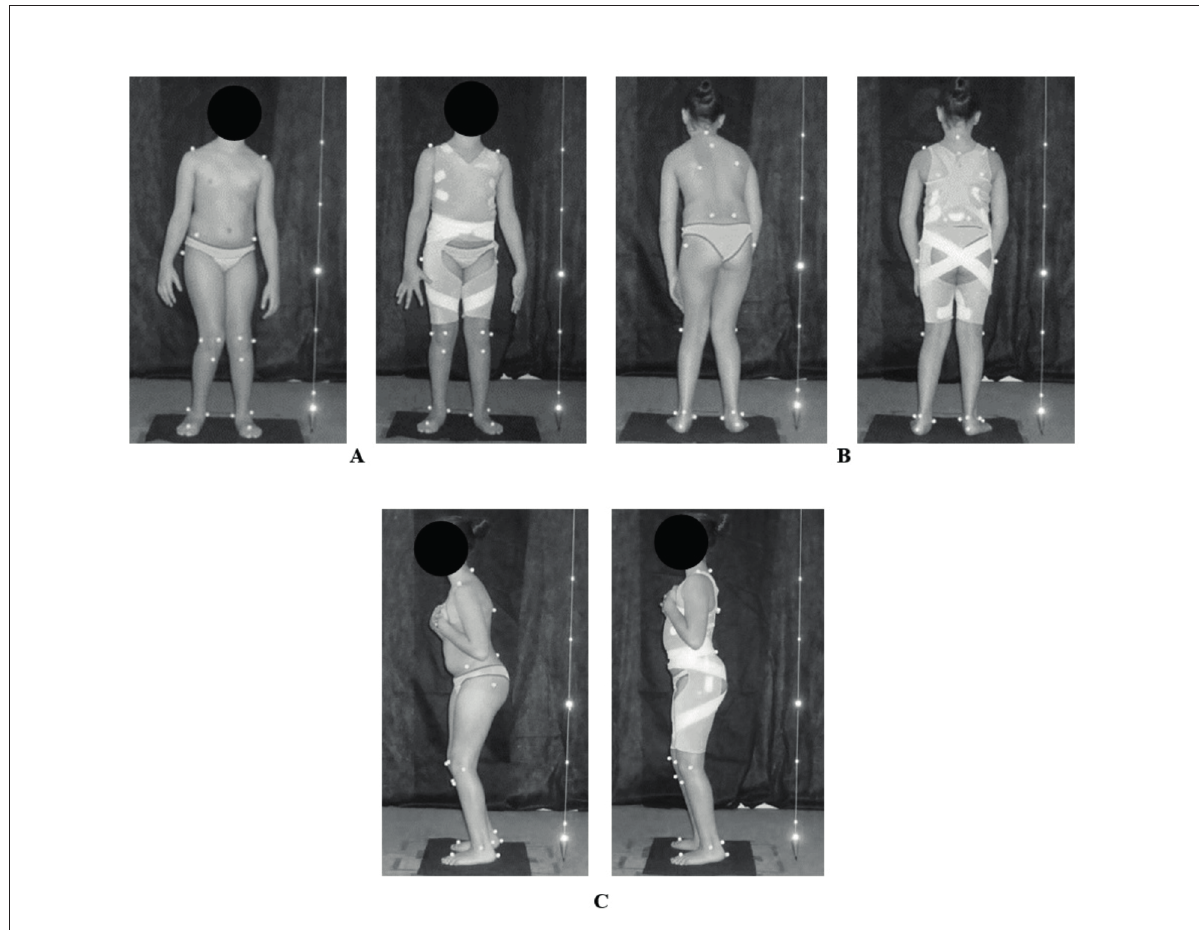
Figure 1 - Child’s posture without TheraTogs ® and with TheraTogs ® , in front view (A), back view (B) and left side view